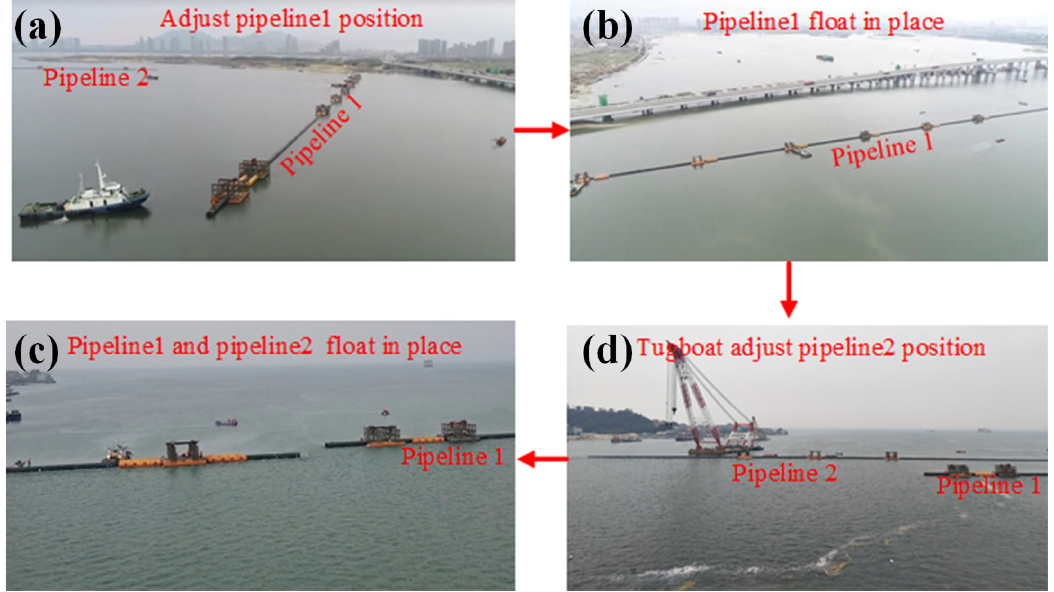
Figure 2. Aerial photo of floating transportation on site.